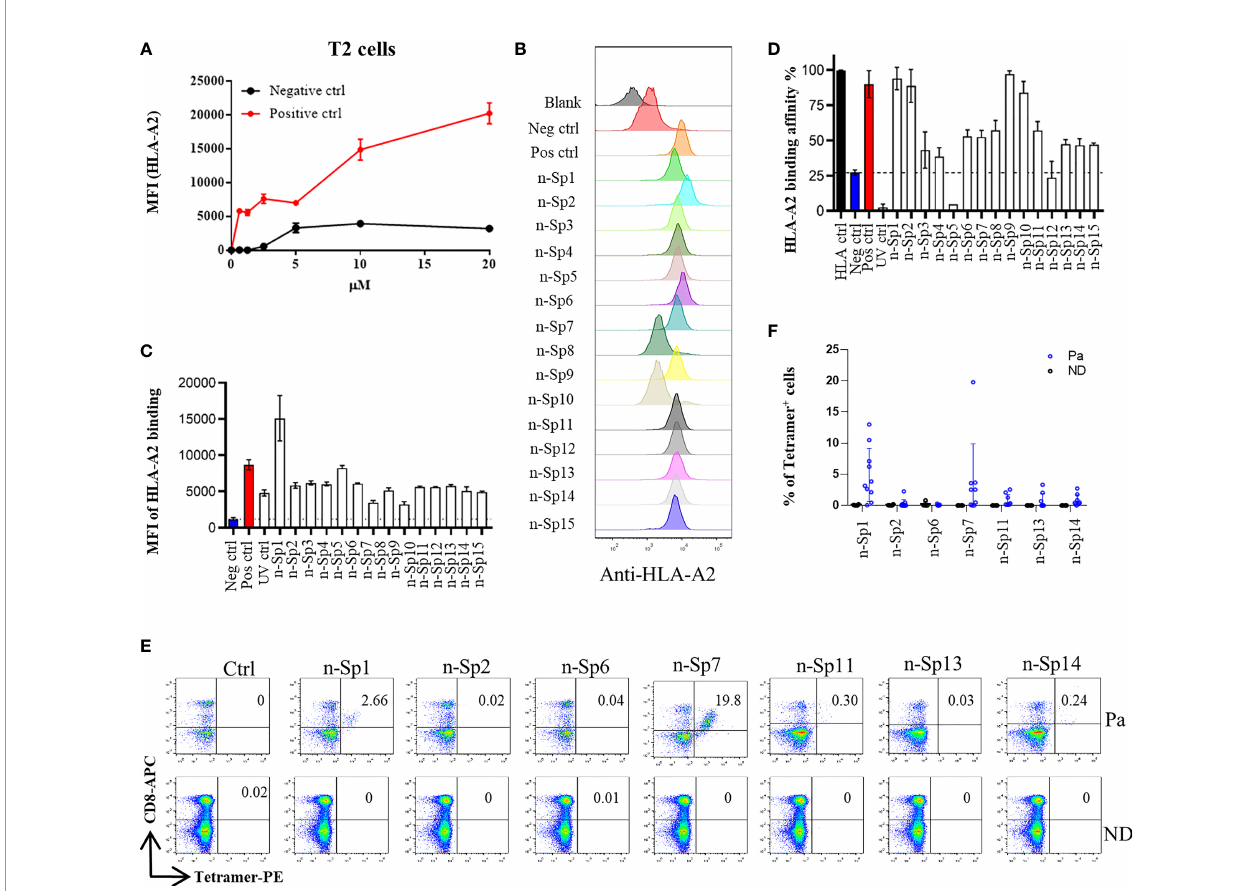
FIGURE 1 | Identi fi cation of HLA-A2-restricted T-cell epitopes in SARS-CoV-2 Spike protein. Establishment of T2 binding assay. T2 cells were incubated with a series of concentrations (0 µM, 0.625 µM, 1.25 µM, 2.5 µM, 5 µM, 10 µM, and 20 µM) of positive control (In fl uenza A M1 peptide M58-66 GILGFVFTL) and negative control (Zika virus P30-38 GLQRLGYVL) peptides. (A) The stabilized HLA-A2 was detected with anti-HLA-A2 fl uorescent antibody fl ow cytometry staining. (B, C) Screening of SARS-CoV-2 epitopes in T2 cells. Predicted peptides named as n-Sp1-15 were synthesized and 10 µM of each peptide was incubated with T2 cells. (B) The binding of peptides on T2 cells was measured with anti-HLA-A2 staining fl ow cytometry. (C) Values indicate the MFI of stabilized HLA-A2. Screening of SARS-CoV-2 epitopes with ELISA. Peptide exchange assay was performed with coated UV-sensitive peptide/MHC complex and given peptides. (D) The binding capability was measured by an anti-HLA-A2 ELISA assay. Blank, no peptides; Neg ctrl, negative control, peptide Zika virus peptide P30-38 GLQRLGYVL; Pos ctrl, positive control, in fl uenza A M1 peptide M58-66 GILGFVFTL; HLA ctrl, UV-sensitive peptide without UV irradiation; UV ctrl, UV-sensitive peptide with UV irradiation. (E, F) Measurement of peptide-speci fi c CD8 + T cells in HLA-A2 + convalescent COVID-19 patients and healthy donors by fl ow cytometry. (E) shows a representative FACS plot and the percentage of tetramer-positive cells is shown in (F) Healthy donors, n = 4; convalescent COVID-19 patients, n = 10. Ctrl: tetramer with UV- sensitive peptide; Pa, convalescent COVID-19 patients; ND, healthy